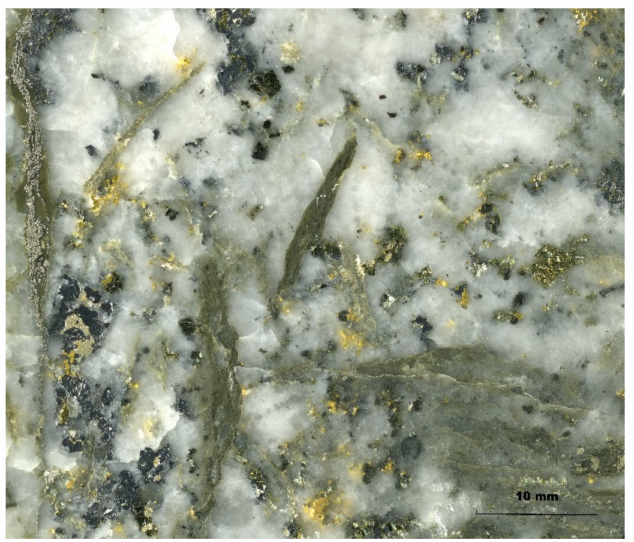
Figure 1. High-grade (c. 2700 g/t Au) LV material from the Crystal Hill mine, Australia. Photograph of sample B1 showing individual coarse gold particles between 500 µ m to 1500 µ m in